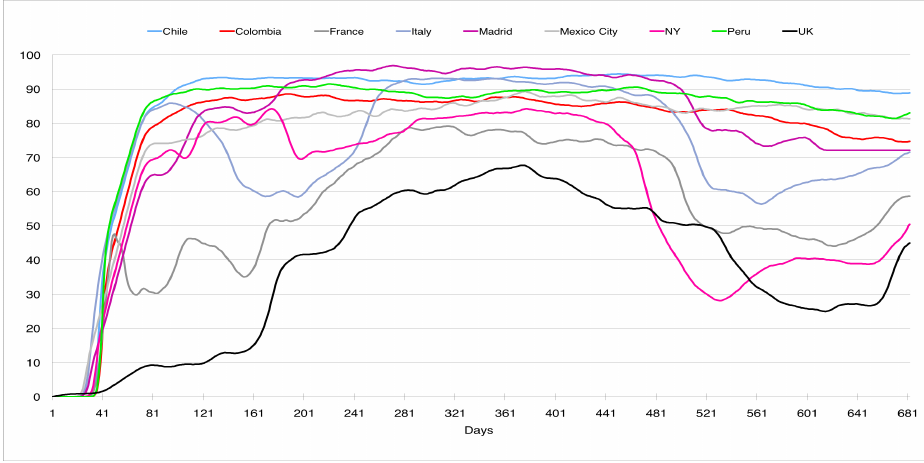
Figure 10. Use of mask in different countries’ cities between 4 April 2020 and 17 December